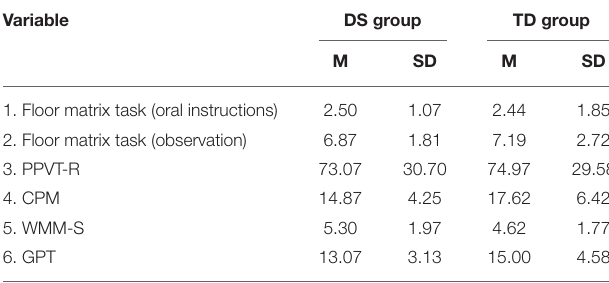
TABLE 1 | Means (M) and standard deviations (SD) for individuals with DS ( N = 30) and typically-developing (TD) children ( N = 32).